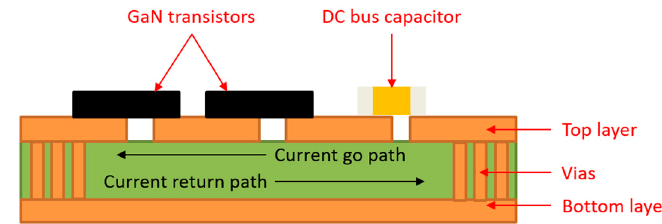
Figure 18. Vertical commutation loop configuration.